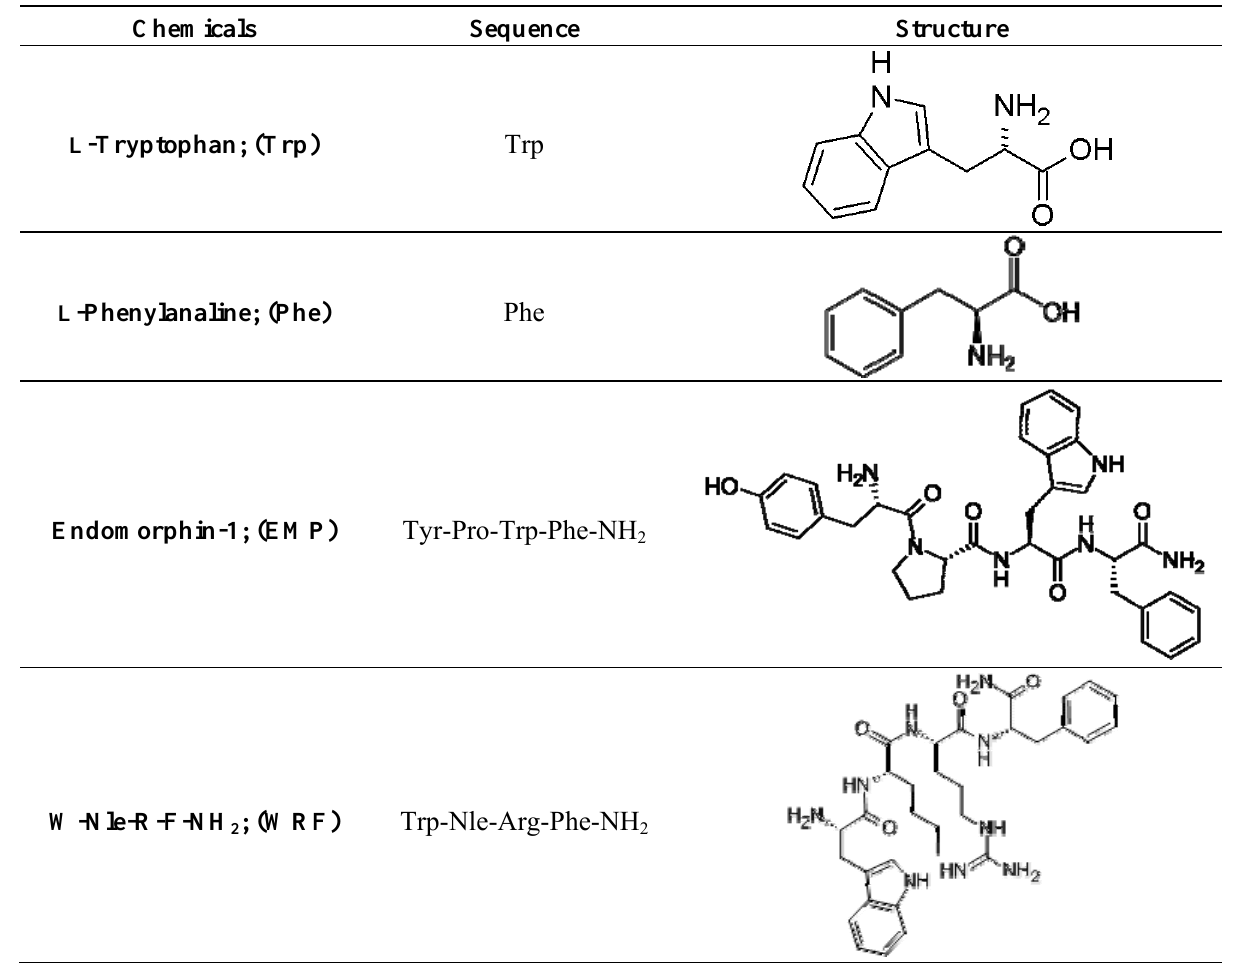
Table 1. Sequence and structure of amino acids and Trp-based peptides. Chemicals Sequence